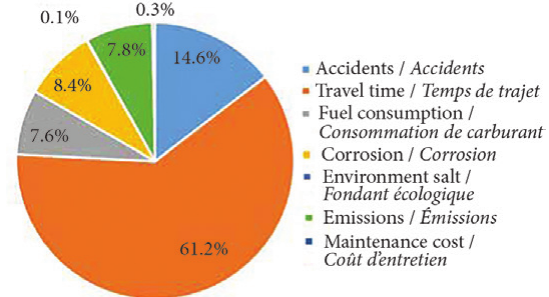
Fig. 1. Setting social and economic factors identified in the Swedish winter road maintenance model (Wallman